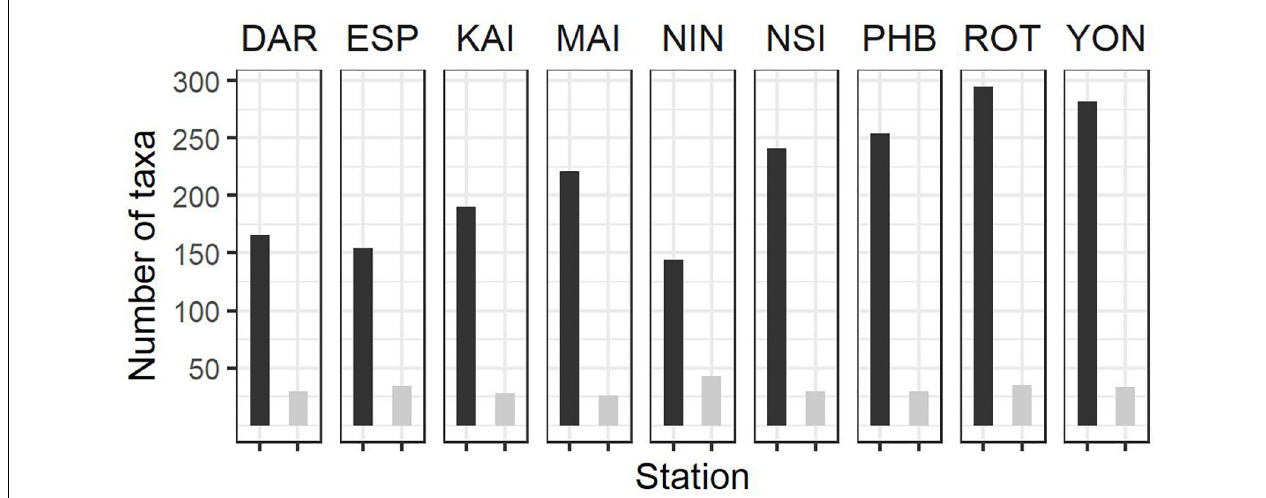
FIGURE 3 | Summary of phytoplankton count data at the NRS (dark bars, total number of taxa per station; light bars, average number of taxa per sample) since IMOS commenced network observations. See Table 1 for start date of IMOS plankton time series at each location. DAR, Darwin ( n = 31); ESP, Esperance ( n = 17); KAI, Kangaroo Island ( n = 47); MAI, Maria Island ( n = 96); NIN, Ningaloo ( n = 12); NSI, North Stradbroke Island ( n = 100); PHB, Port Hacking ( n = 100); ROT, Rottnest Island ( n = 87); YON, Yongala ( n = 96) where n = number of samples counted at each station.